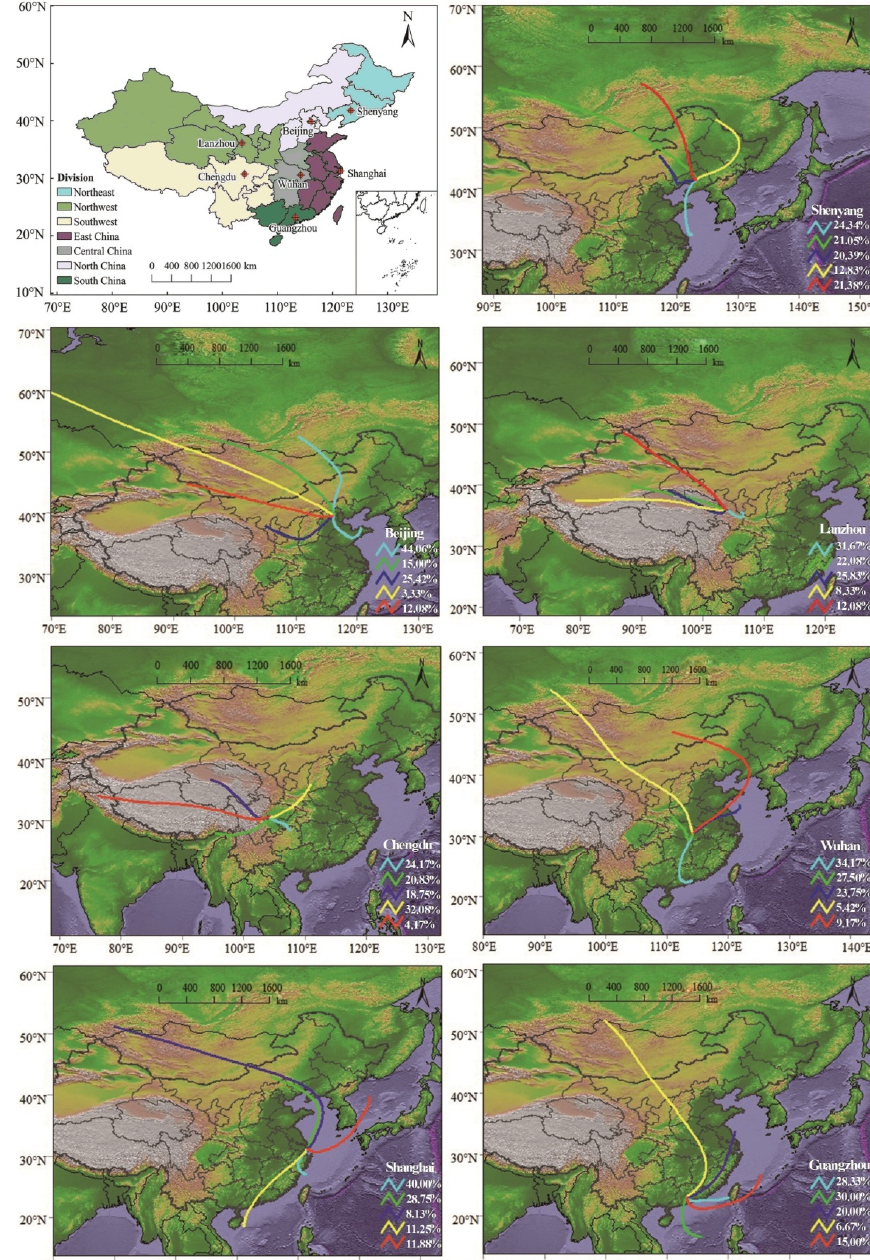
Figure 13. The cluster of airflow backward trajectory in seven typical cities from 2005 to